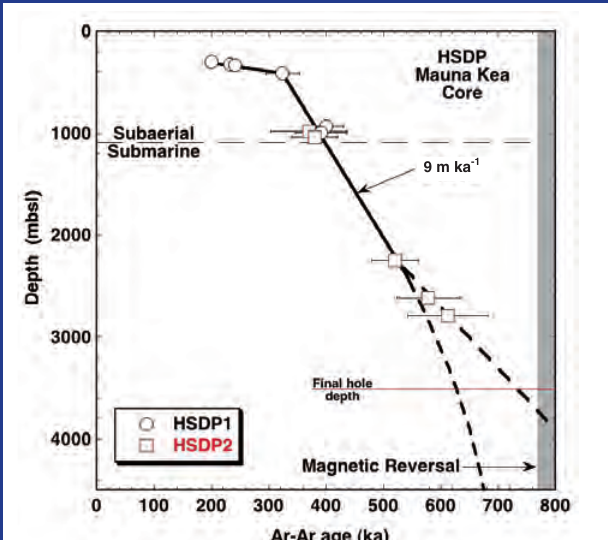
Figure 6. Depth versus age for core samples from HSDP1 and HSDP2 (data from Sharp et al., 1996; Sharp and Renne, 2004). Horizontal solid line indicates the final bottom hole depth of 3508 meters. Dashed lines show possible age-depth relations allowed by the data for the bottom portion of the core. Distinguishing between the allowed models requires additional geochronological and geomagnetic data from the lowermost portion of the